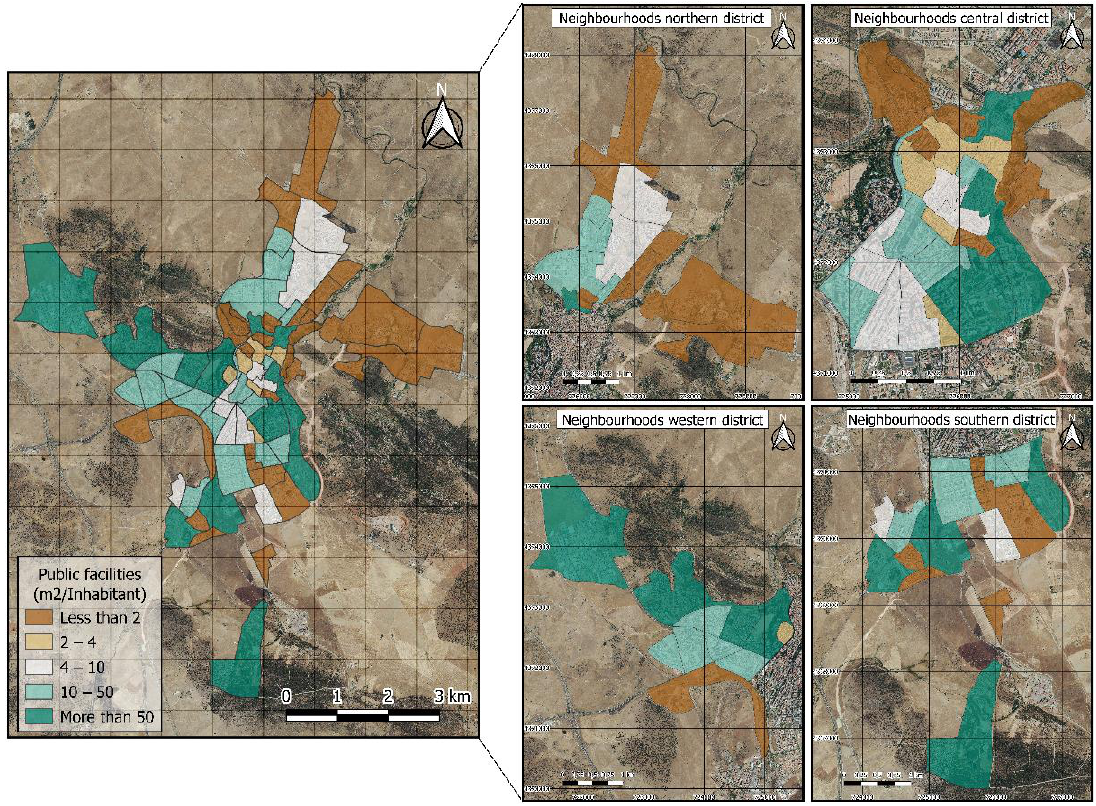
Figure 7. Public facilities.